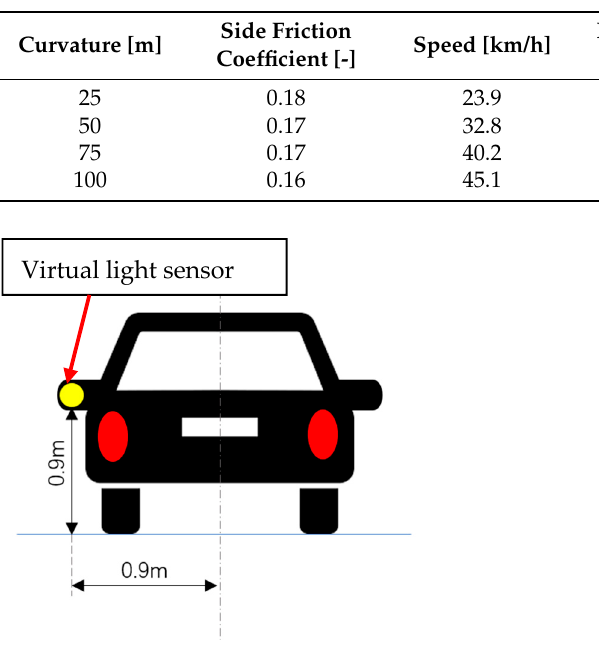
Figure 7. The position of the virtual light sensor, which corresponds to the ADB test fixture from SAE J3069 [26].